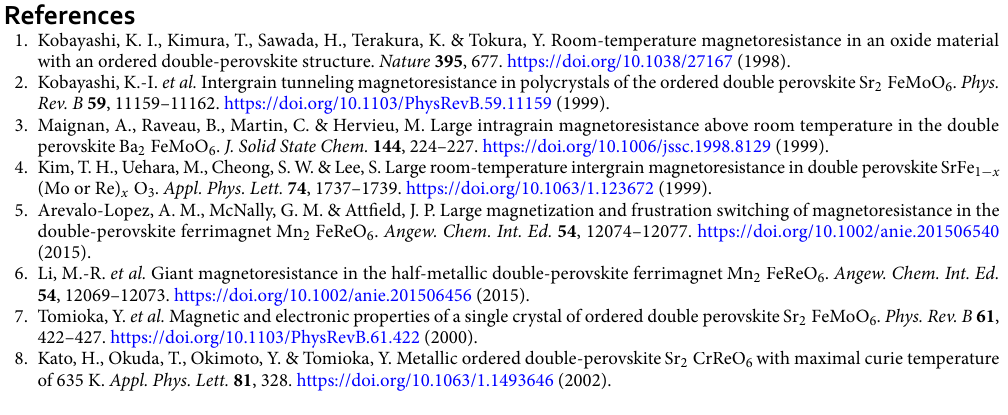
Figure 8. Spin-magnetization density isosurface plots for ( a ) undoped and ( b ) Cr-doped Lu 2 NiIrO 6 ( Lu 2 Ni 0.5 Cr 0.5 IrO 6 ) materials at the same iso-value of ± 0.04 e /Å the spin up and spin down states,